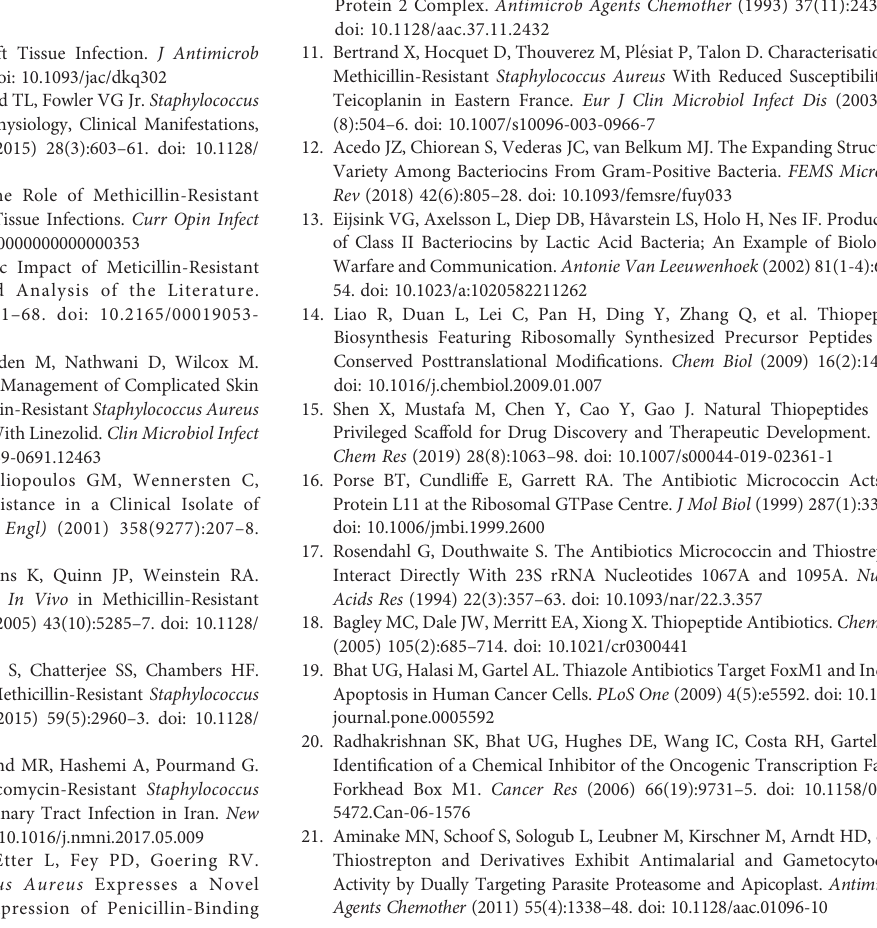
Supplementary Figure 1 | Microtiter plate checkerboard assay scheme. See description in Materials and Methods. Supplementary Figure 2 | MP1 production by S. equorum WS 2733 and S. equorum KAVA at different temperatures. Supplementary Figure 3 | RPC elution pro fi le of MP1 from diluted 2-propanol cell-extract of S. equorum KAVA. B. RPC HPLC purity analysis of the active fractions from the puri fi cation. MP1 elution peaks are indicated with